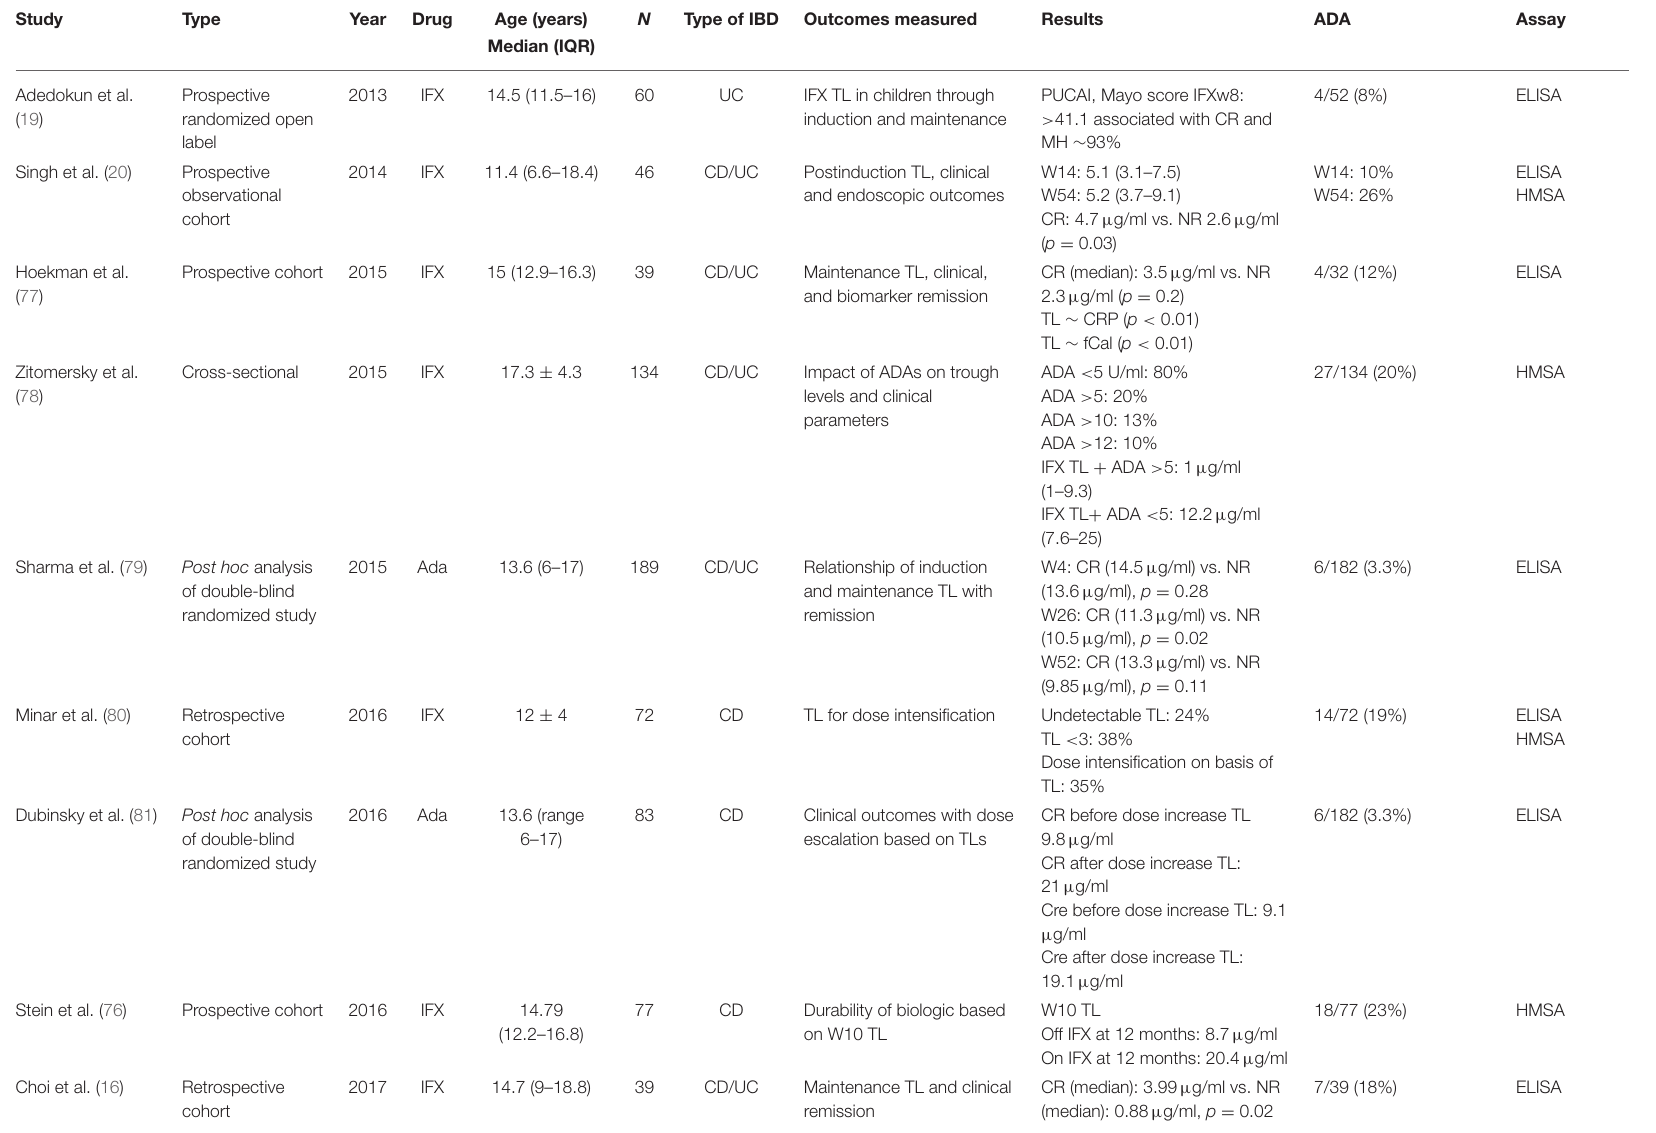
TABLE 1 | Summary of pediatric studies utilizing TDM for biologic efficacy.